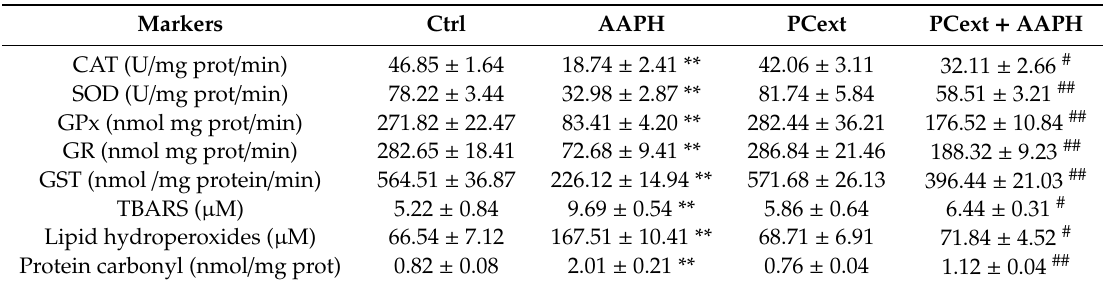
Table 2. Biomarkers of oxidative damage in